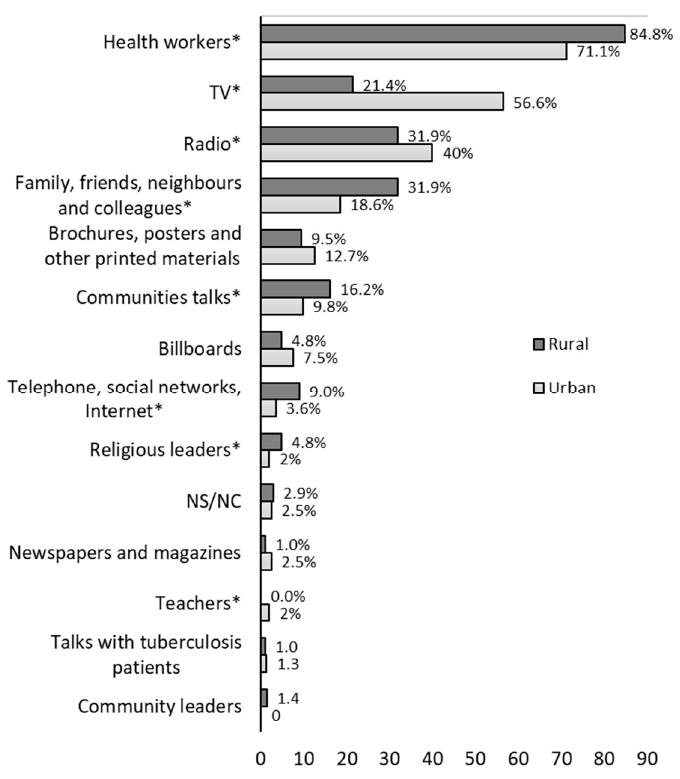
Figure 3. What are the sources of information that, in your opinion, can most effectively reach people like you with information about tuberculosis? * Significant chi-square test of differences by area at 5% level.